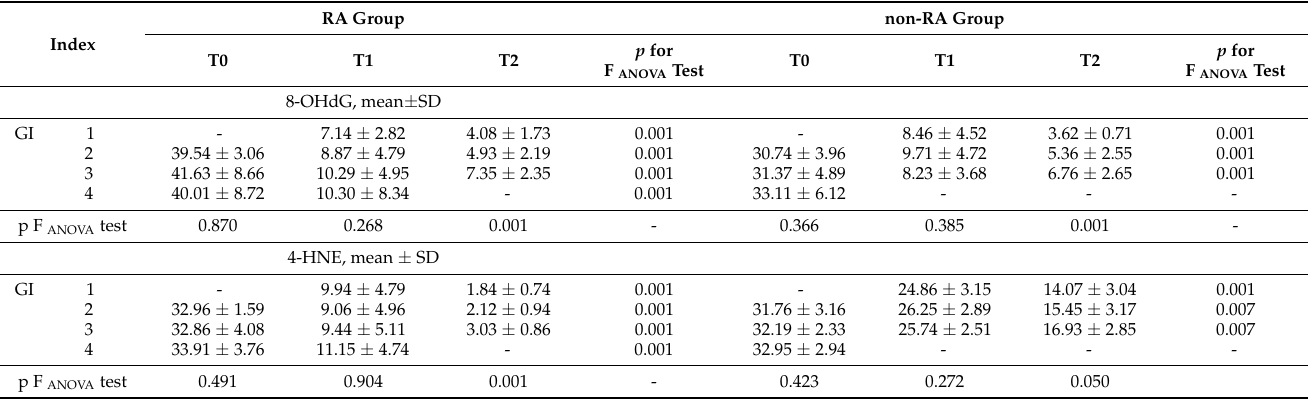
Table 5. Association between 8-OhdG and 4-HNE and GI, PBI, or